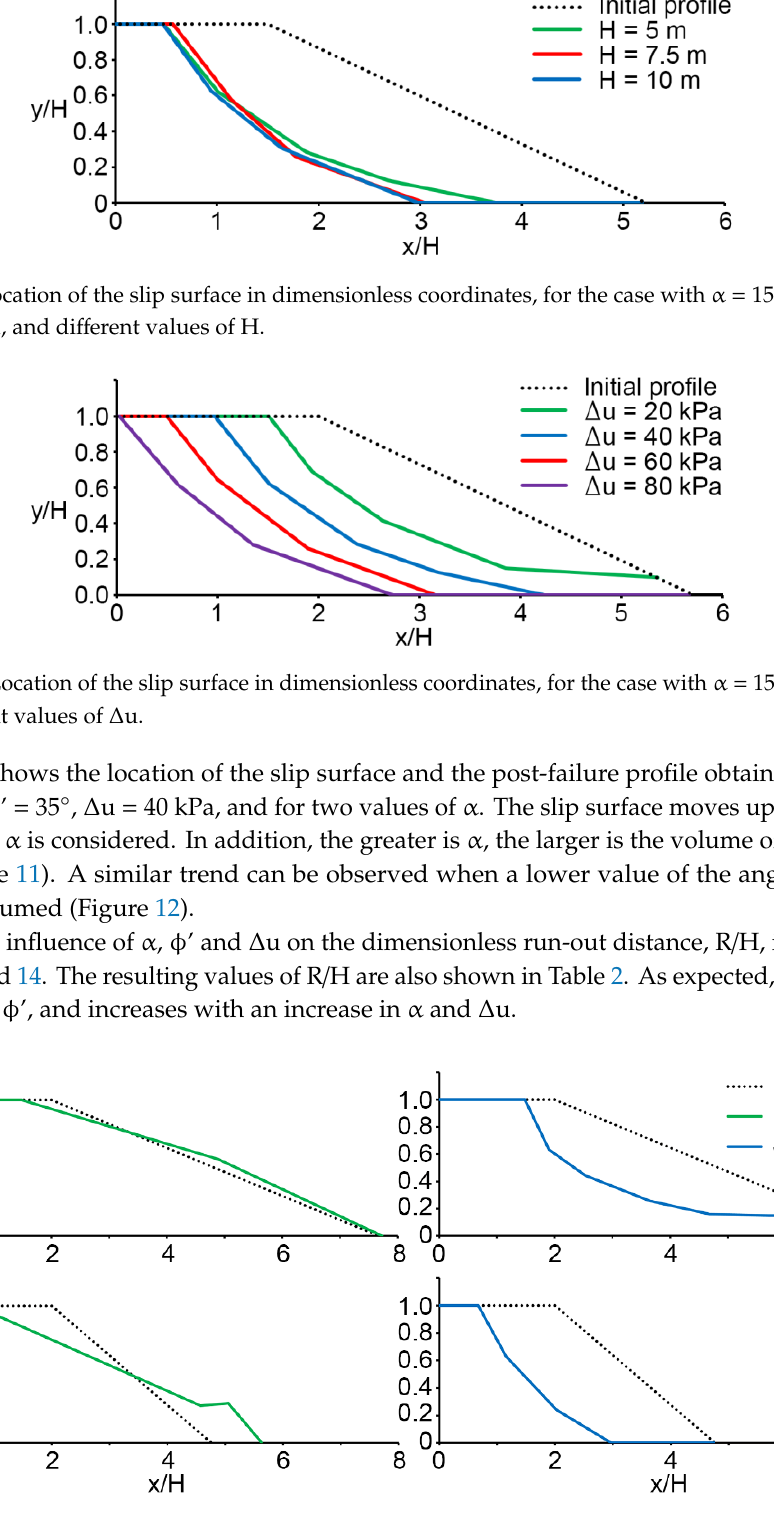
Figure 8. Dimensionless post- failure profiles for the case with α = 15°, φ’ = 35° and different values of Δu and H.